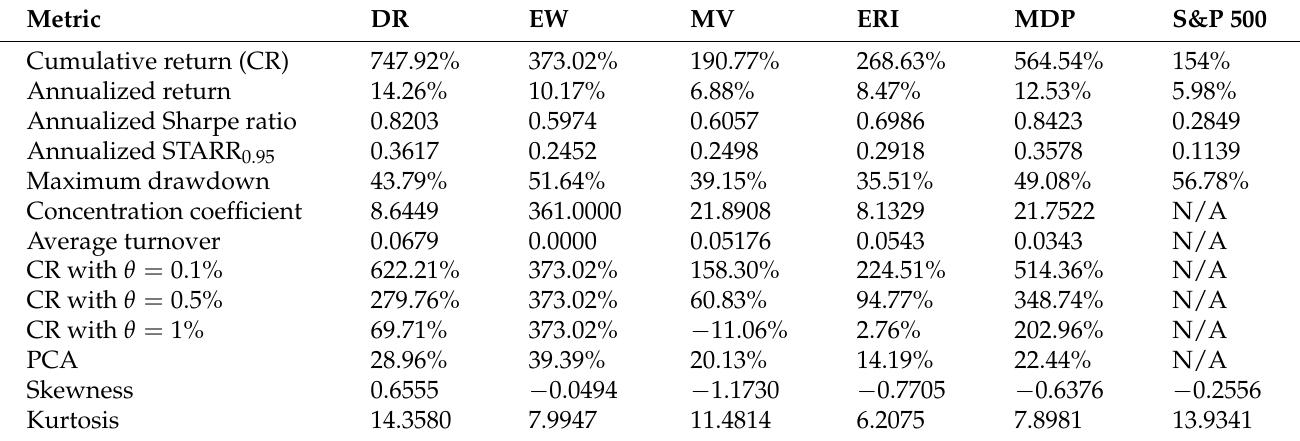
Table 2. Performance comparisons for DR, EW, MV, ERI, MDP, and S&P 500 index for the 361-stock